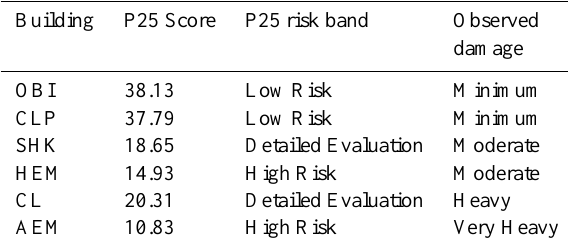
Table 6. P25 Scores and observed damages for